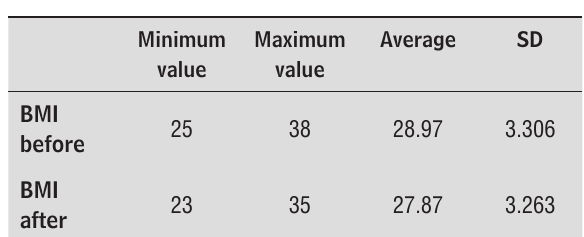
Table 4 - Body Mass Index (BMI) of ESF users before and after an intervention program in SUS, Iguaí, 2010